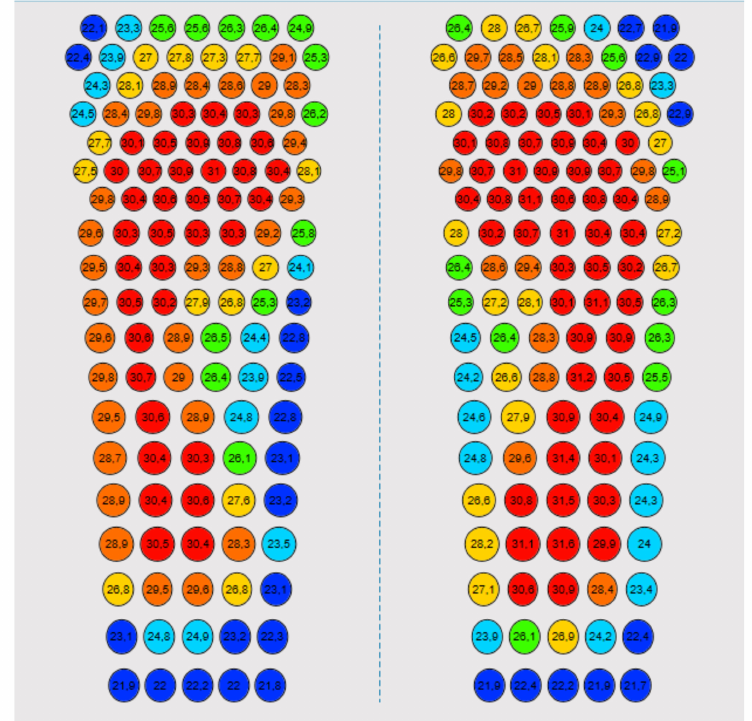
Figure 2. The grid of temperature sensors of the platform system with an example of temperature values recorded by each of the 120 sensors per foot. The sensor color shown in the figure indicates temperature ranges: dark blue indicates temperatures below 23.3 ◦ C, light blue from 23.3 ◦ C to 24.9 ◦ C, green from 25.0 ◦ C to 26.5 ◦ C, yellow from 26.6 ◦ C to 28.2 ◦ C, orange from 28.3 ◦ C to 29.9 ◦ C and red above 29.9 ◦